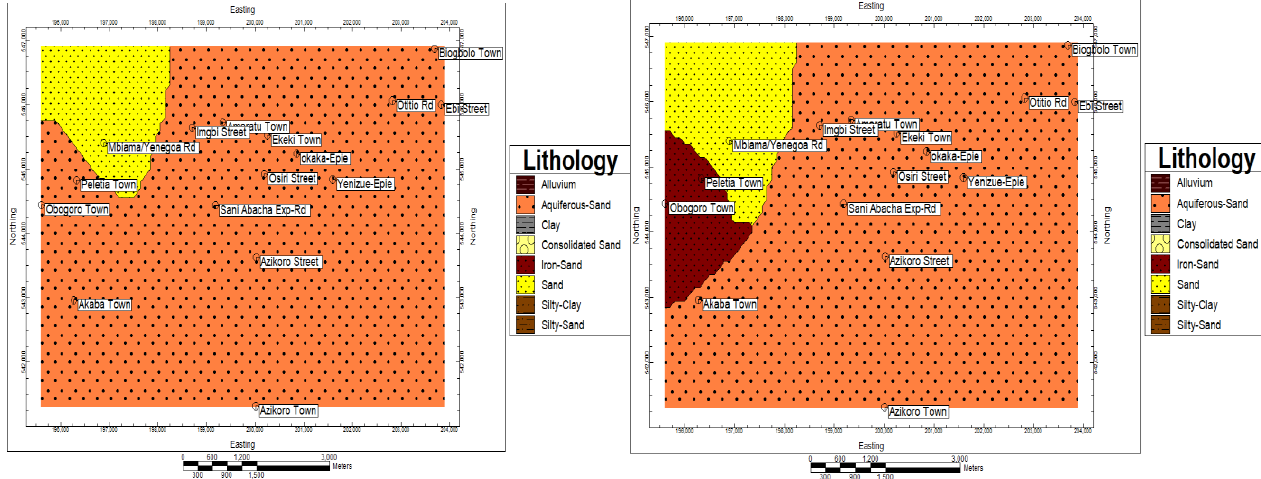
Figure 7: Lithology Maps across the Study